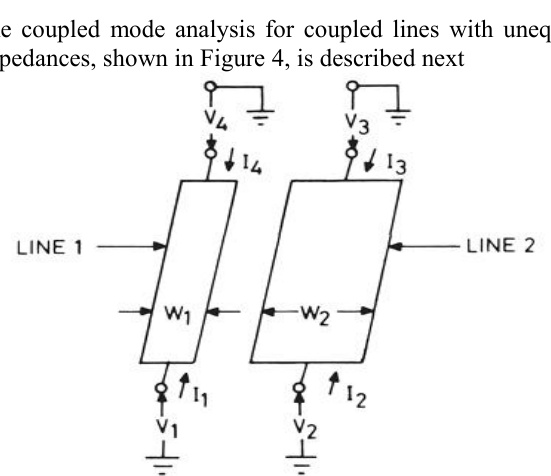
Figure 4: A pair of coupled lines with unequal